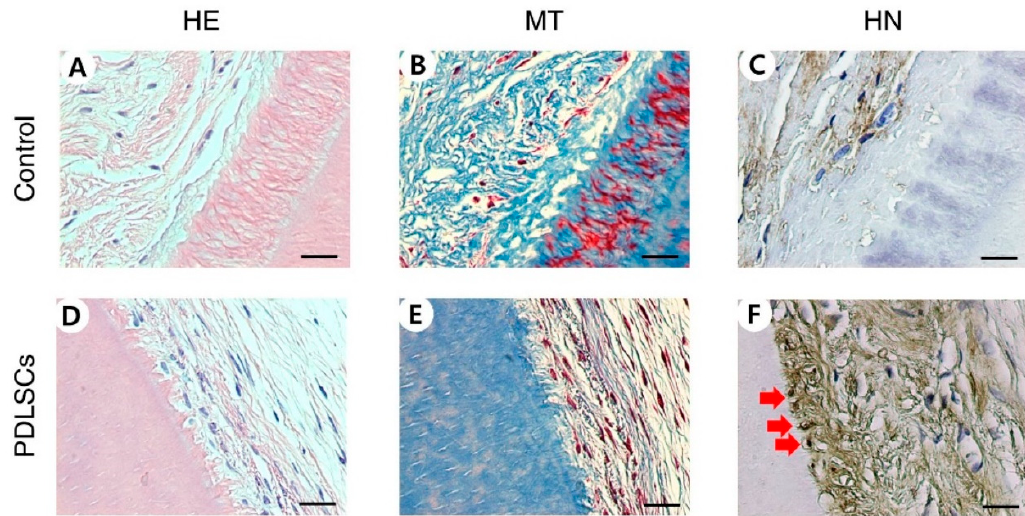
Figure 1. Histological characteristics of PDLSC recellularization on dHPDL transplants. HE staining ( A , D ), MT staining ( B , E ), HN staining ( C , F ), HE, MT, and HN staining showed that dHPDL transplants were contributed to recellularization of cells, indicated by red arrows. Scale bars: 20 μ m. Abbreviations: PDLSC, periodontal ligament stem cells; dHPDL, decellularized human periodontal ligament; HE, hematoxylin and eosin; MT, Masson’s trichrome; HN, human nuclei.